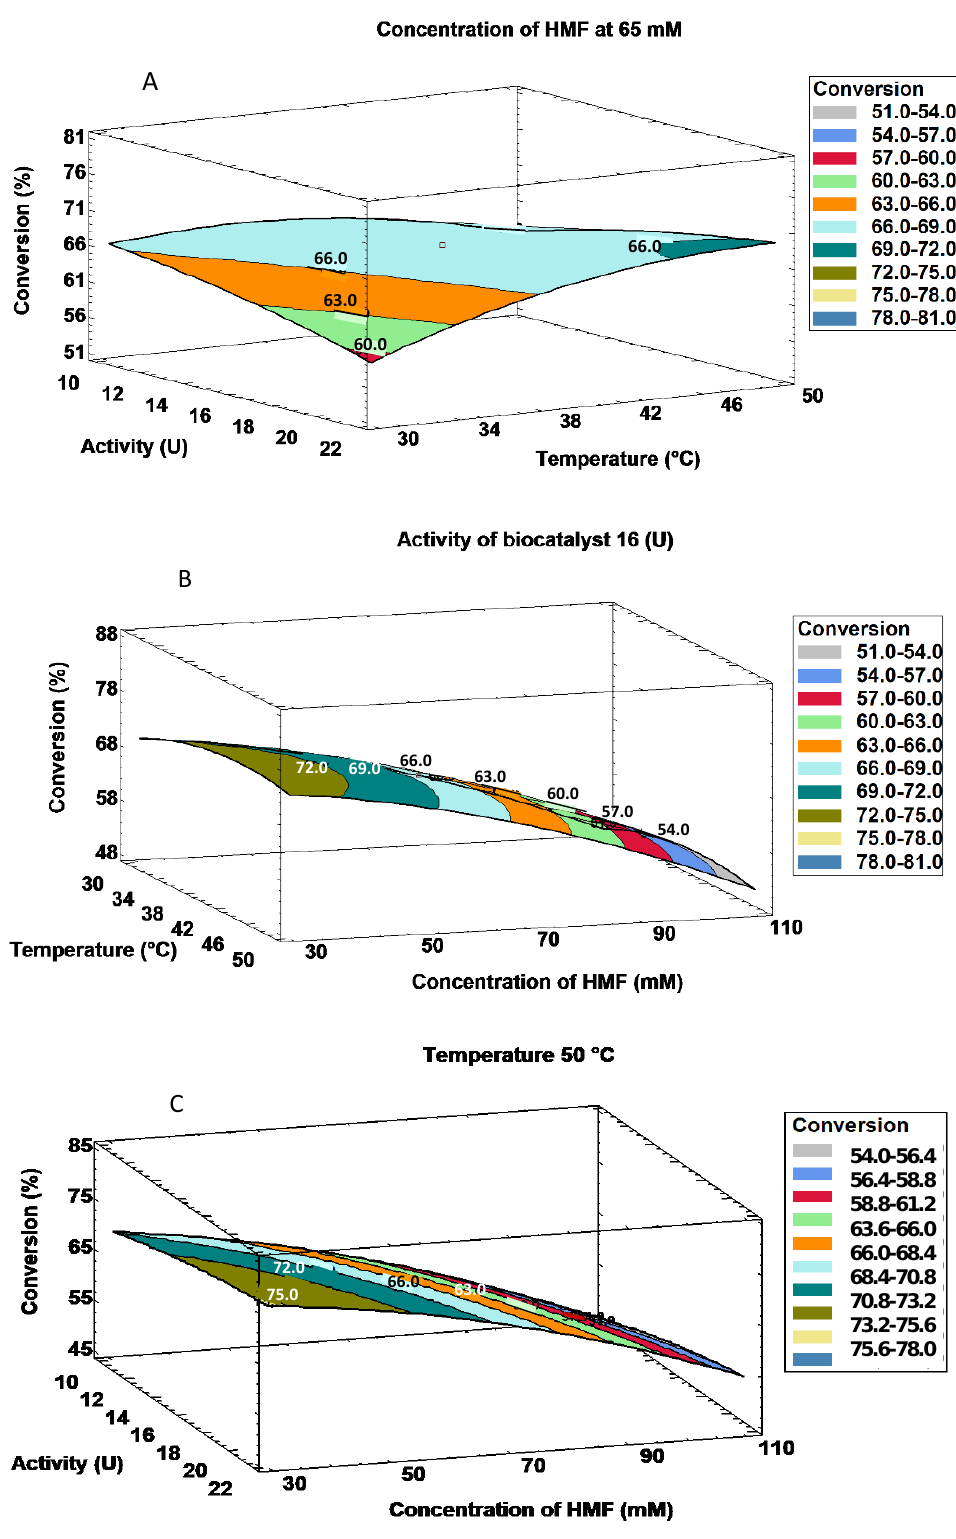
Figure 5. Effect of the variables studied on the conversion of HMF esterification with lauric acid (1000 mM) using immobilized TL lipase. ( A ) Response surface for concentration of HMF, ( B ) response surface for the activity of biocatalyst, and ( C ) response surface for temperature.